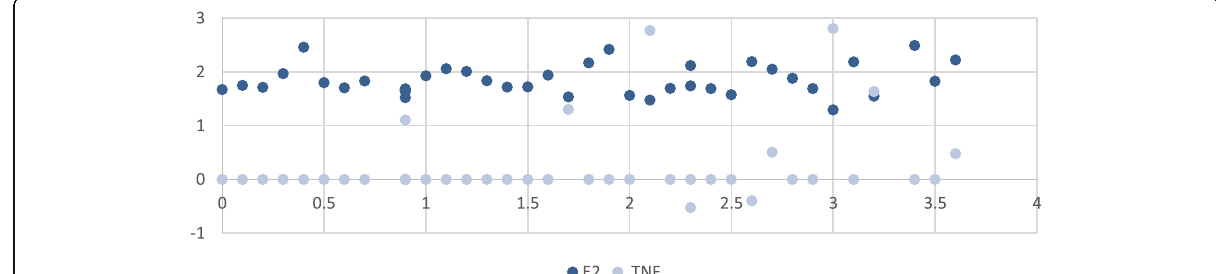
Fig. 3 Correlation between estrogen levels and tumor necrosis factor alpha (TNF- α ) levels in